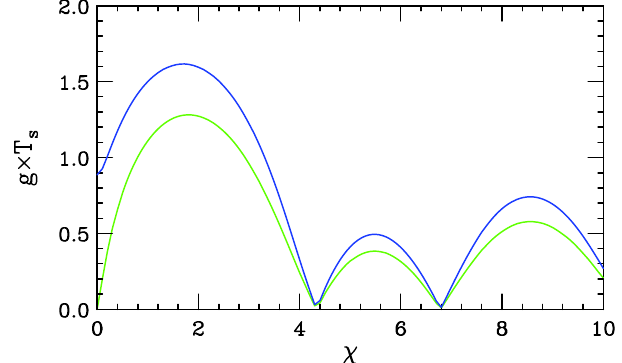
as a function of χ according s